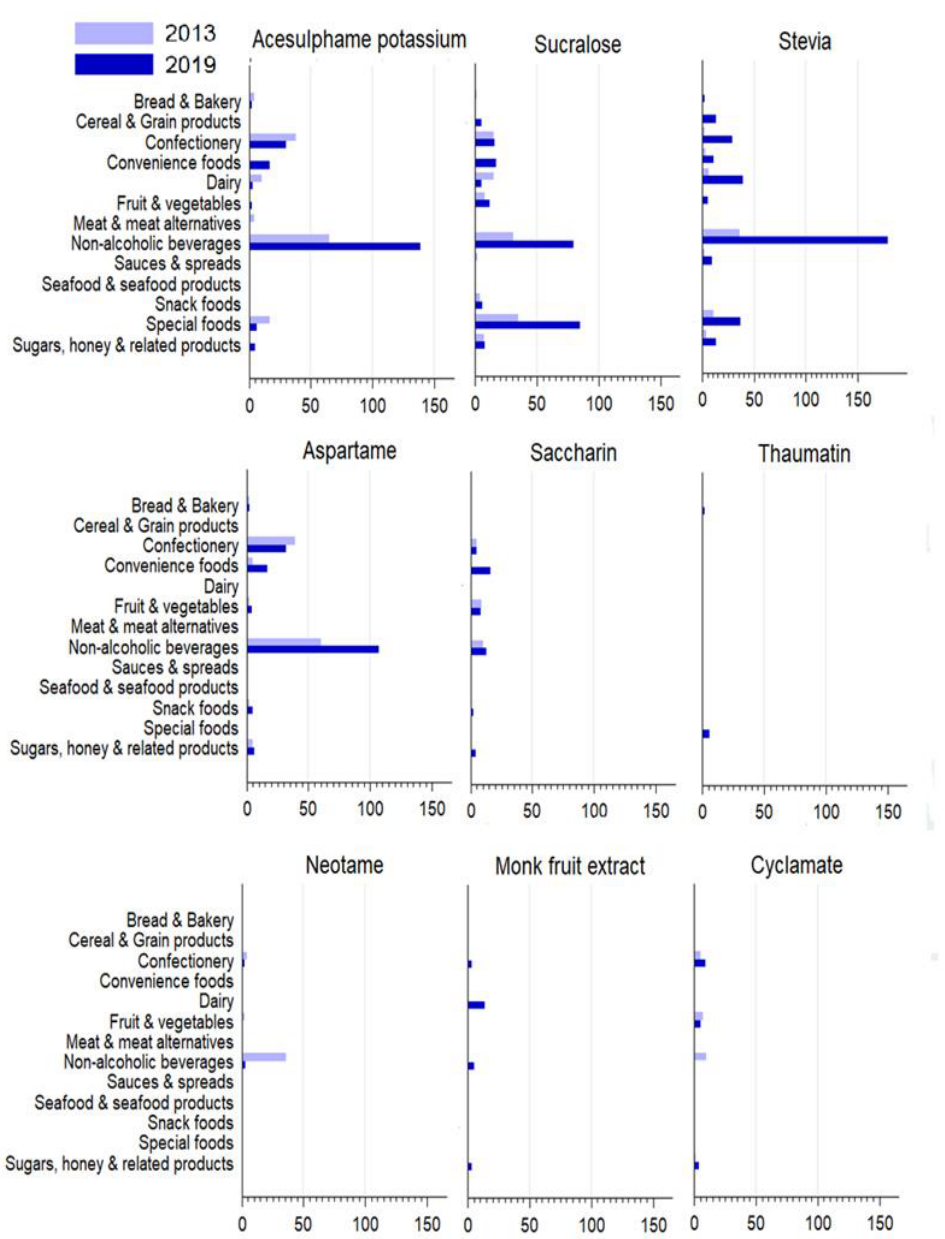
Figure 1. Number of the nine most used NNS in New Zealand packaged foods by major food categories (Categories, Eggs and Edible oils and emulsions, have been excluded).